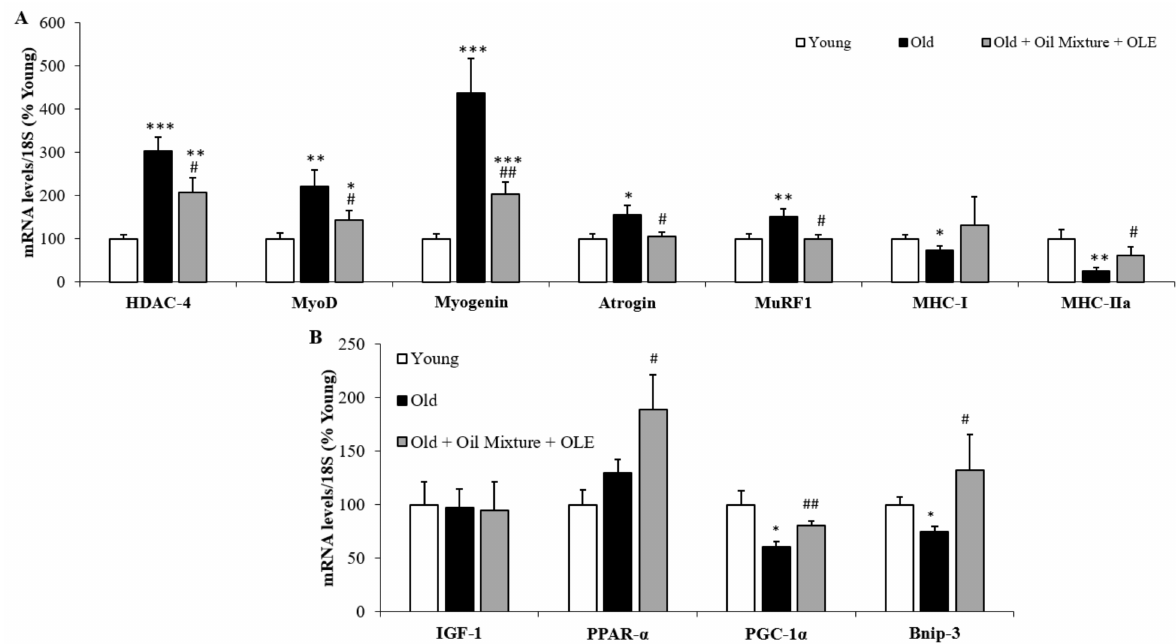
Figure 5. Gastrocnemius mRNA concentrations of Histone deacetylase 4, Myoblast determination protein 1, Myogenin, Atrogin, Muscle RING-finger protein-1, Myosin heavy chain I and myosin heavy chain IIa ( A ); and Insulin growth factor 1, peroxisome proliferator activated receptor α , PPAR γ coactivator 1 α and Bnip-3 ( B ) of young rats, old rats and old rats treated 21 days with the Oil Mixture and the OLE. Values are represented as mean ± SEM. * p < 0.05 vs. Young; ** p < 0.01 vs. Young; *** p < 0.001 vs. Young; # p < 0.05 vs. Old; ## p < 0.01 vs.